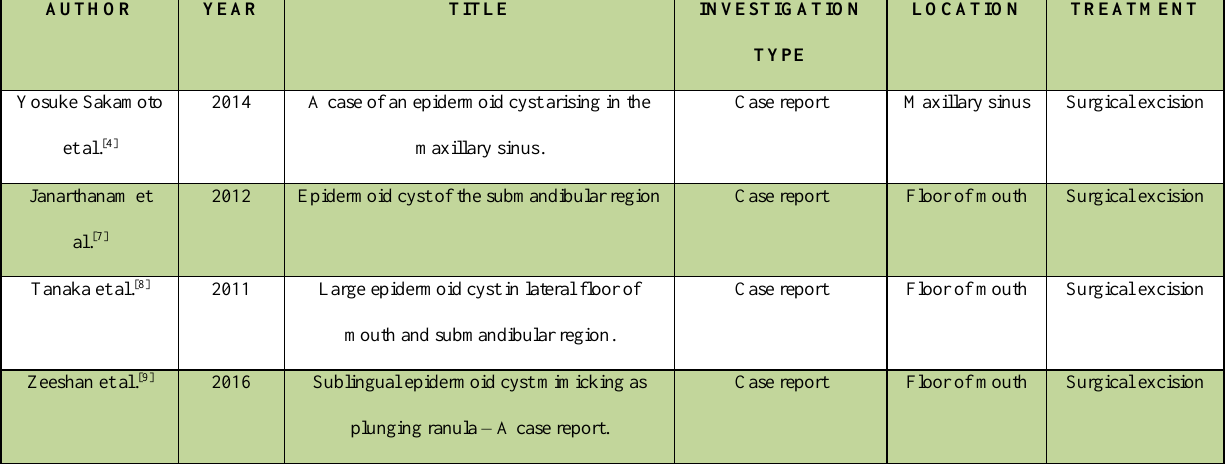
Table 1. Review of the literature about the most frequent locations of EC in the maxillofacial region.